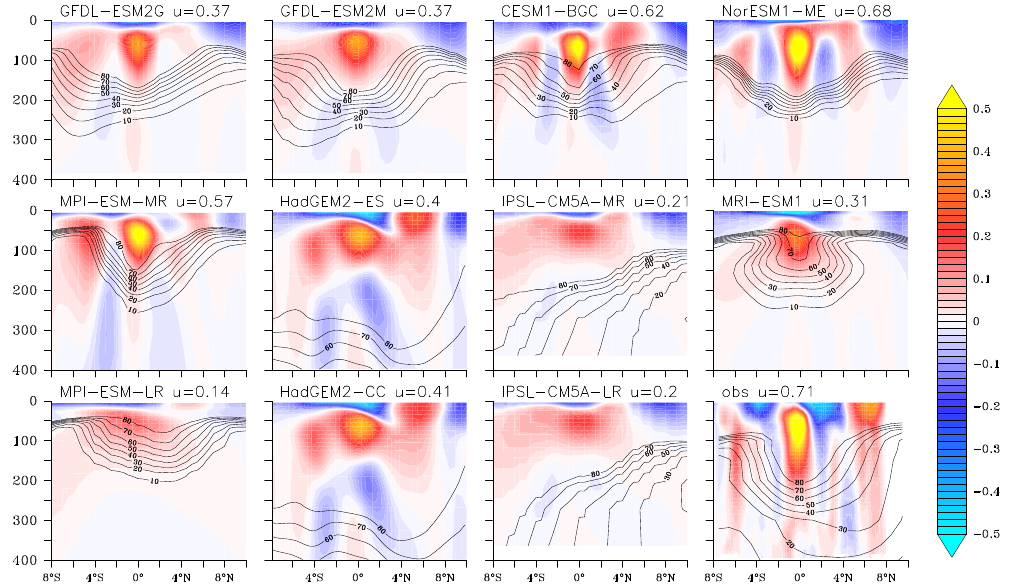
Figure 4. Average equatorial ventilation (represented by the zonal component of velocity, ms − 1 , shown in colours) and oxygen concentration (shown as black contour lines for 10, 30, 40, 50, 60, 70, and 80mmolm − 3 , respectively) in CMIP5 models and observations (last panel), with depth along a 95 ◦ W longitude section in the tropical west Pacific (10 ◦ N to 8 ◦ S latitude). Observed u velocity is from Johnson et al. (2002) while the oxygen observations are from WOA09. The dominant current shaping the OMZ in the east–west direction is the Equatorial Undercurrent, revealed by the high (red to yellow) velocities at the equator. The maximum intensity of the EUC is labelled next to the model name (in ms − 1 ).